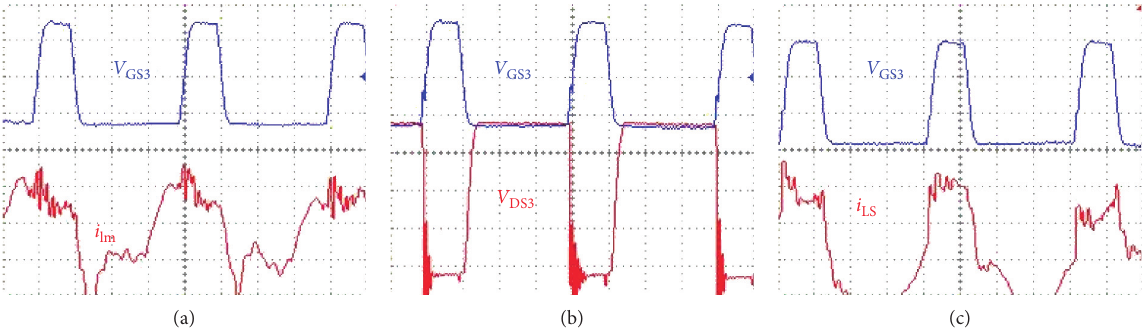
Figure 13: SISO mode results (buck operation) (scale: 5V/DIV, 2 A/DIV, and 2.5 us/DIV). (a) Gate signals V i . (b) Gate signals V lm